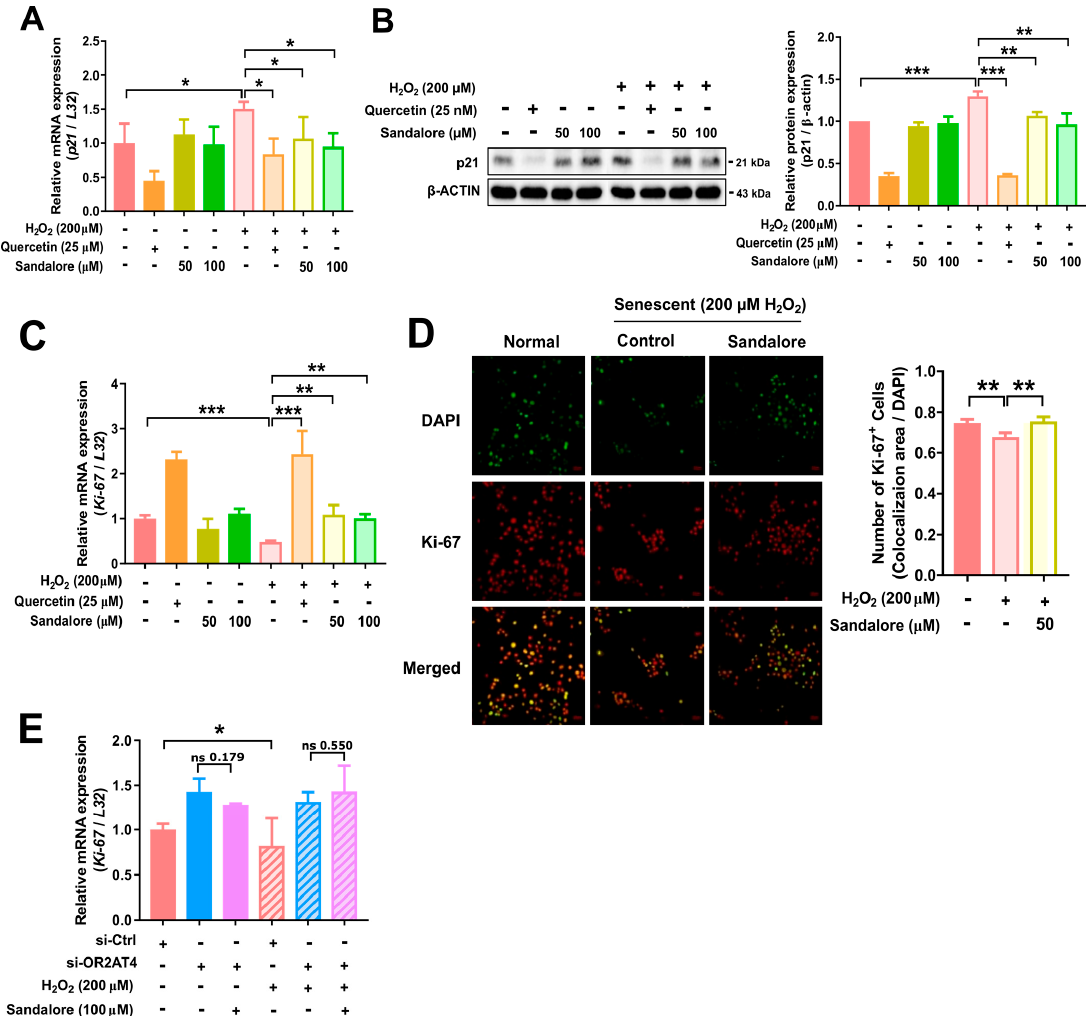
Figure 4. Sandalore suppressed senescence as assessed by the expression of p21 and Ki-67. ( A ) The mRNA expression of p21 in non-senescent and senescent cells. ( B ) Immunoblot analysis of p21. The relative protein expression of p21 was analyzed using ImageLab software. ( C ) Relative mRNA expression of Ki-67 . ( D ) Representative images of immunocytochemical staining in HaCaT cells. Immunolocalization of Ki-67 (red) and DAPI (green): the merged image (yellow) shows colo- calization of DAPI and Ki-67 in HaCaT cells. DAPI staining was imaged using correctly adjusted acquisition settings and was displayed in a green pseudo color. Scale bar, 50 µm (left panel). Ki-67- positive HaCaT cells (right panel) were quantified using ImageJ software. ( E ) Relative mRNA